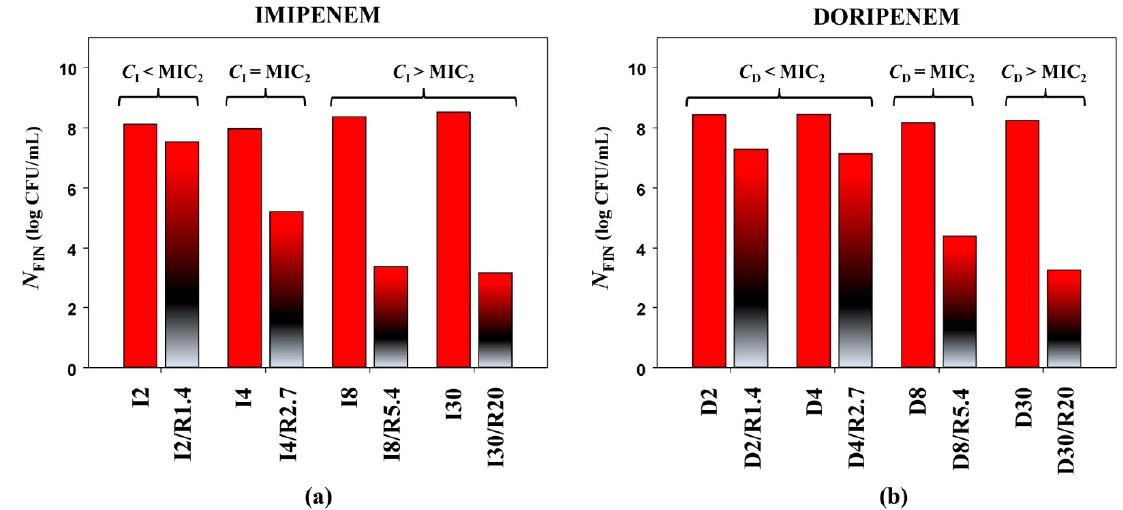
Figure 2. Antimicrobial effects of imipenem ( a ) and doripenem ( b ) (expressed as N FIN ), alone and in combination with relebactam against K. pneumoniae 16 (MIC 2 —MIC obtained with the PK-based method).